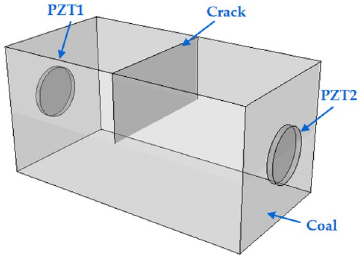
Figure 4. Simulation model of coal crack monitored by PZT.